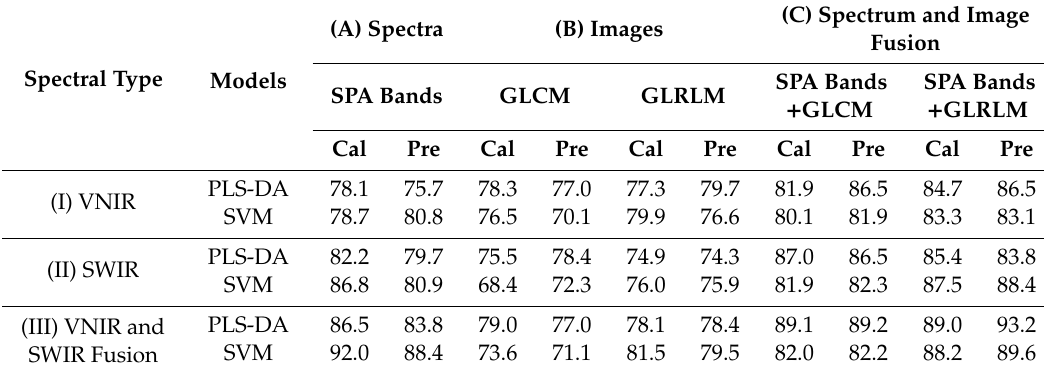
Table 3. The classification accuracies (%) in SPA bands with PLS-DA and SVM models (Cal and Pre are the abbreviations of calibration dataset and prediction